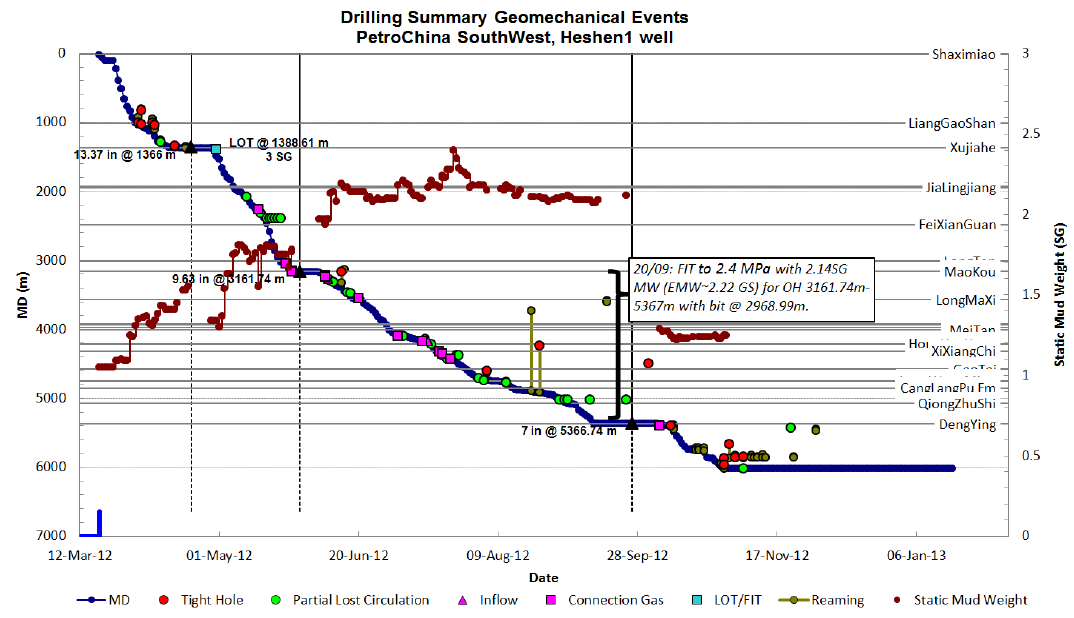
Figure 1. Geomechanical events during drilling of H1.